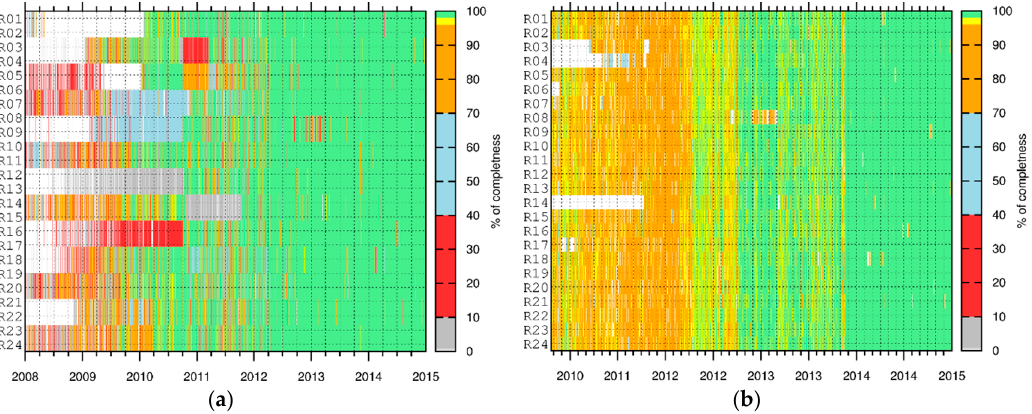
Figure 7. ( a ) The completeness of 30 s GLONASS (where each GLONASS satellite is shown with their pseudorandom noise numbers (PRN) number on the y axis) satellite clock corrections. ( b ) The completeness of 5 s GLONASS (where each GLONASS satellite is shown with their pseudorandom noise numbers (PRN) number on the y axis) satellite clock corrections. Note that the 5 s GLONASS clock corrections are only available from the end of 2010 onwards.